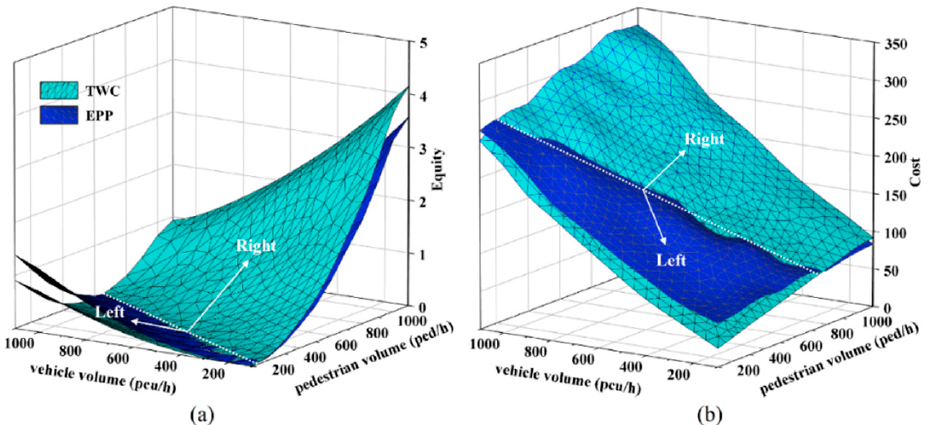
Figure 6. Impacts of pedestrian and vehicle demand: ( a ) Transportation equity comparison; ( b ) transportation cost comparison.